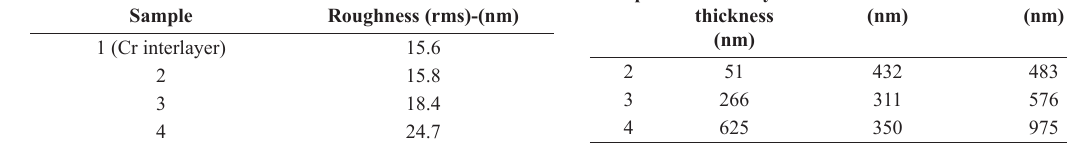
Table 2. Roughness (rms) of the Cr interlayer and of samples 2, 3, and 4. Sample